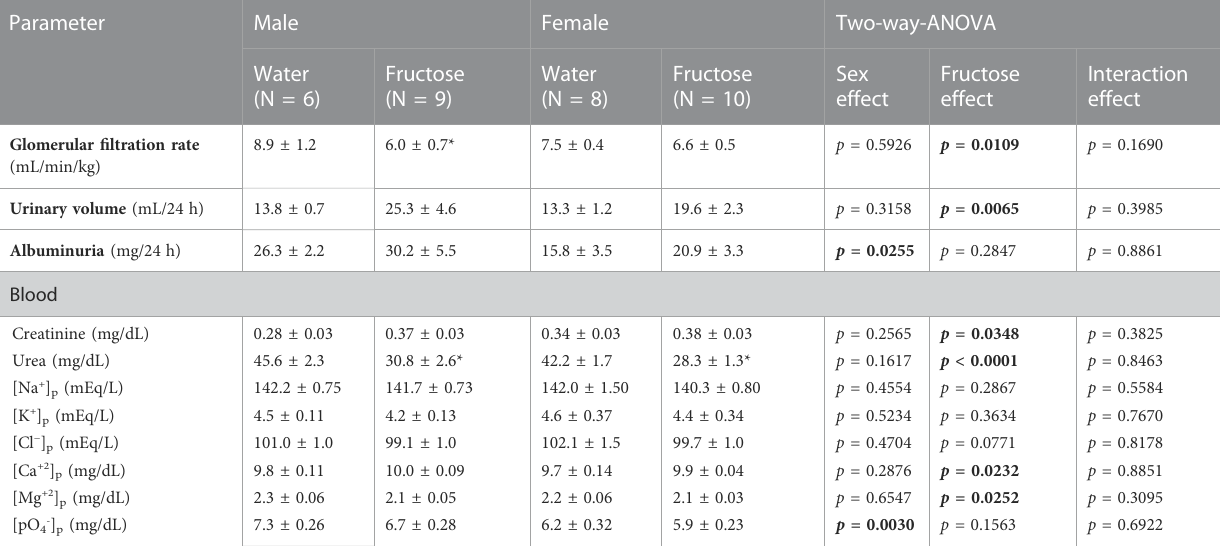
TABLE 2 Summary of urinary and blood parameters observed in rats submitted to fructose overload. Parameter